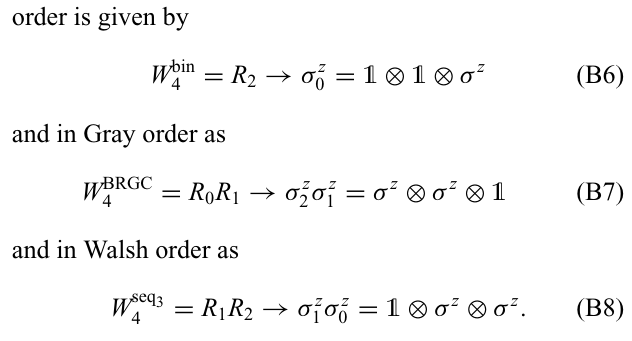
FIG. 15. The first three Rademacher